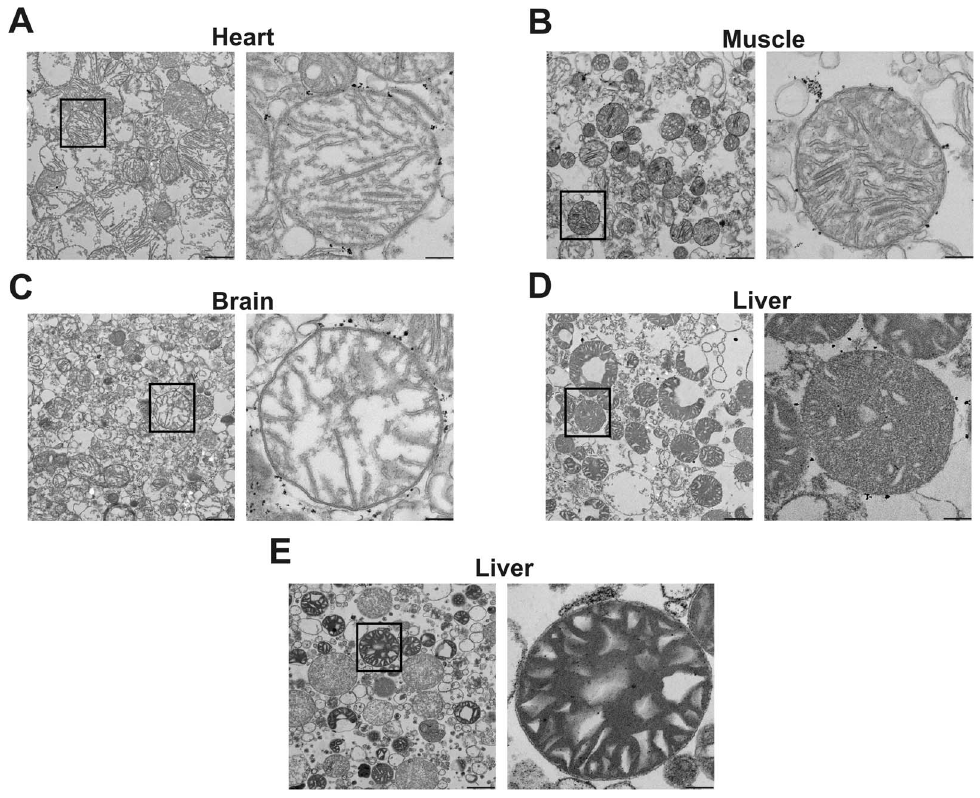
Figure 2. The anti-TOM22 magnetic beads method yields intact mitochondria. Anti-TOM22 magnetic beads method was applied to purify mitochondria from A heart, B skeletal muscle, C brain and D liver tissues. Mitochondria were isolated by differential centrifugation technique from E liver tissue. Mitochondrial morphology was investigated by transmission electron microscopy from four biological samples per group and representative pictures are shown. Pictures were taken at 4,000 6 (left panel) and 20,000 6 (right panel) magnification and black bars display 1 m m (left panel) and 200 nm (right panel), respectively. Black dots at the outer membrane in A, B, C and D pictures represent anti-TOM22 magnetic beads.